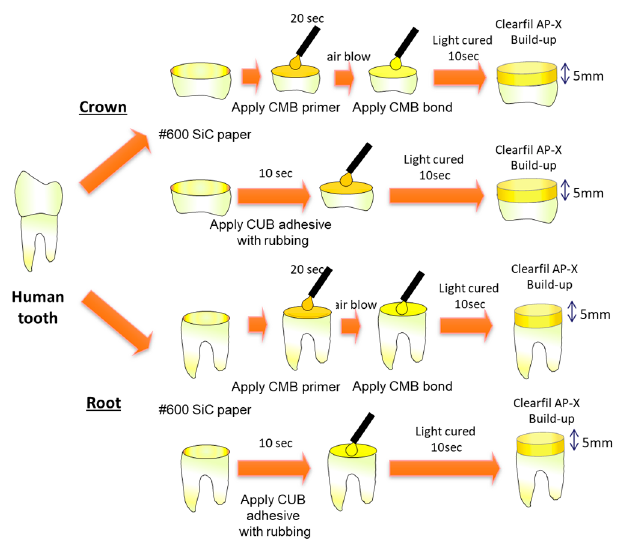
Figure 1. Procedure for specimen preparation.